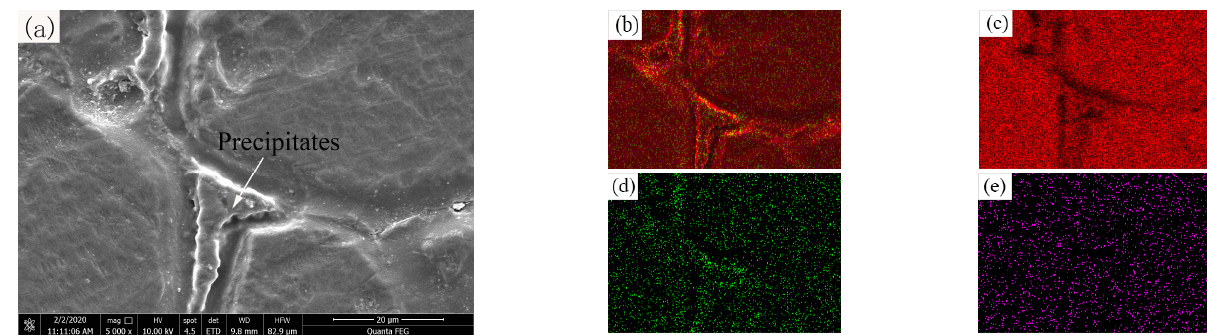
Figure 11. SEM/EDS images for OABs of aluminum wires with a 160 A overcurrent: ( a ) SEM image; ( b ) total element mapping; ( c ) Al mapping; ( d ) O mapping; ( e ) Cl mapping.